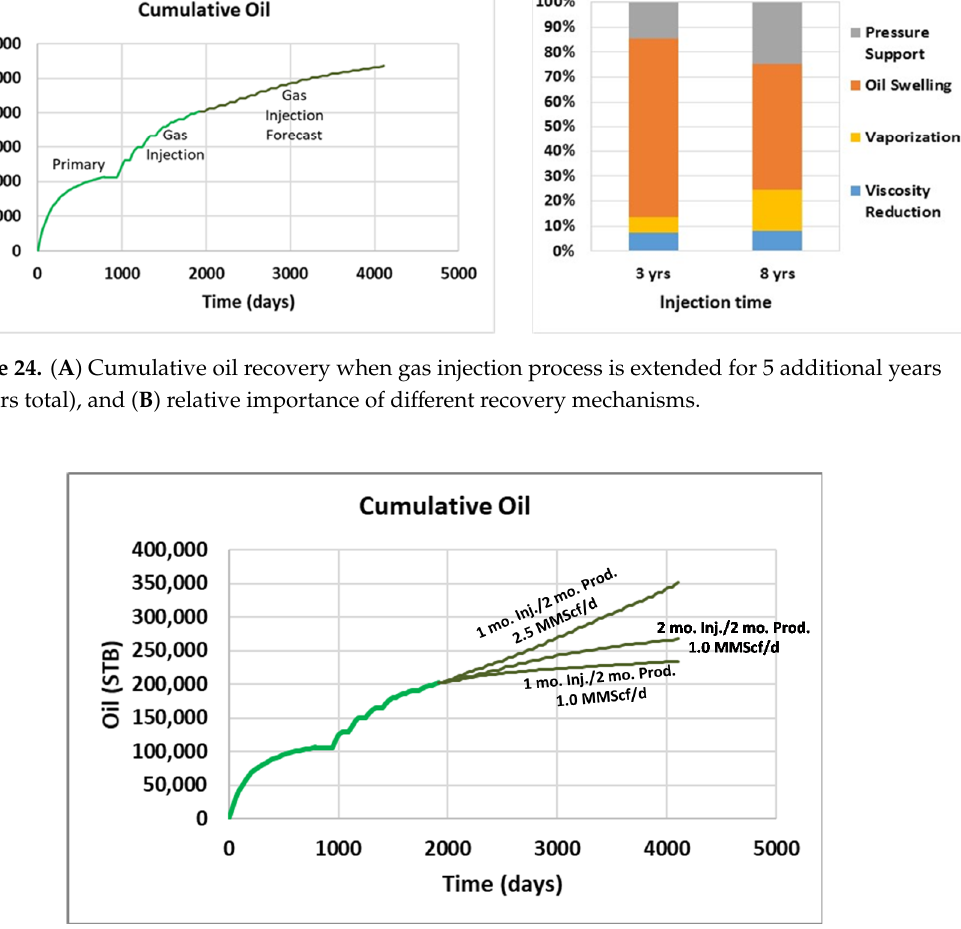
Figure 25. Total oil production when combining shorter injection cycles with higher injection rates.